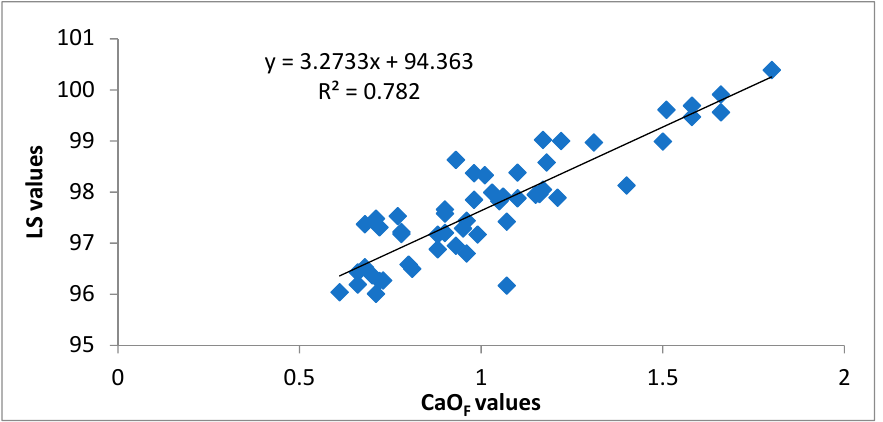
Figure 11. Correlation analysis for the components for clinker. Source: own source.